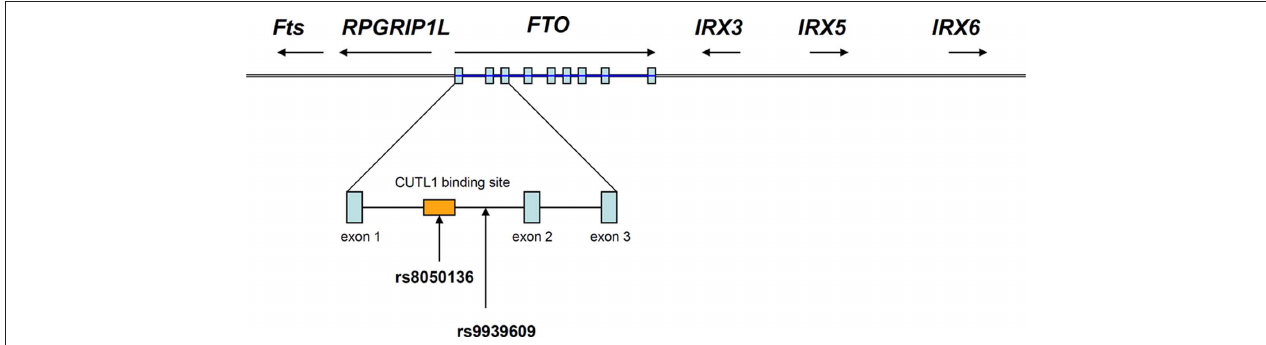
FiGurE 1 | Genomic organization of FTO and its neighboring genes (not drawn to scale). The FTO gene contains nine exons which are depicted in blue rectangles and the most replicated FTO SNP rs9939609 is found in intron 1 of the gene. CUTL1 binding site overlaps with the FTO SNP rs8050136 (Stratigopoulos et al.,